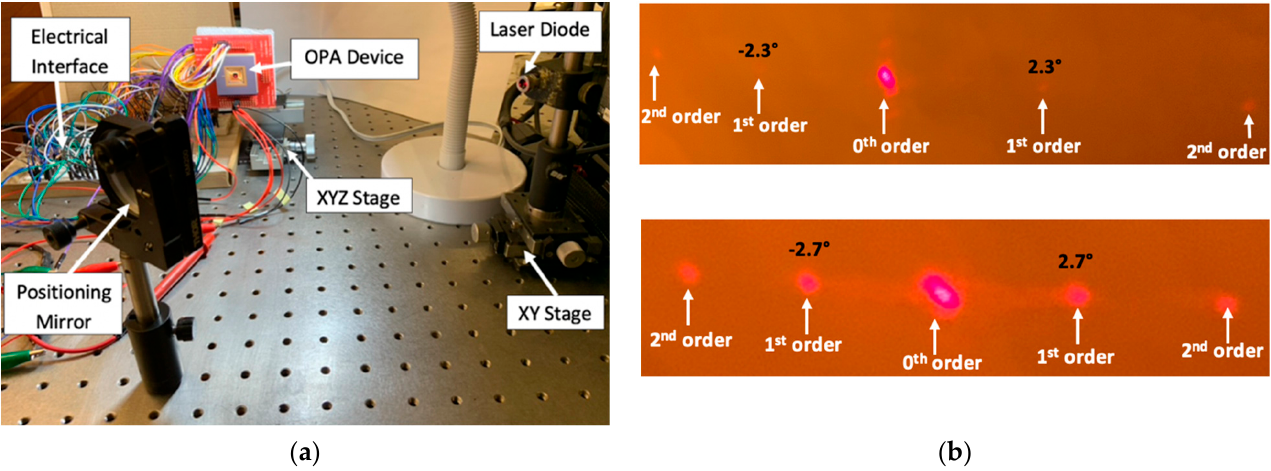
Figure 6. ( a ) Image of the experimental setup used to generate diffraction profiles and laser steering; ( b ) comparison of diffraction profiles created by active OPA ( top ) and pitch-tuning OPA ( bottom ).